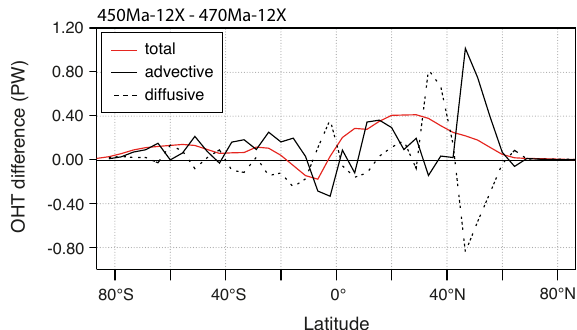
Figure 9. Difference in total, advective and diffusive OHT between the 450Ma-12X and the 470Ma-12X